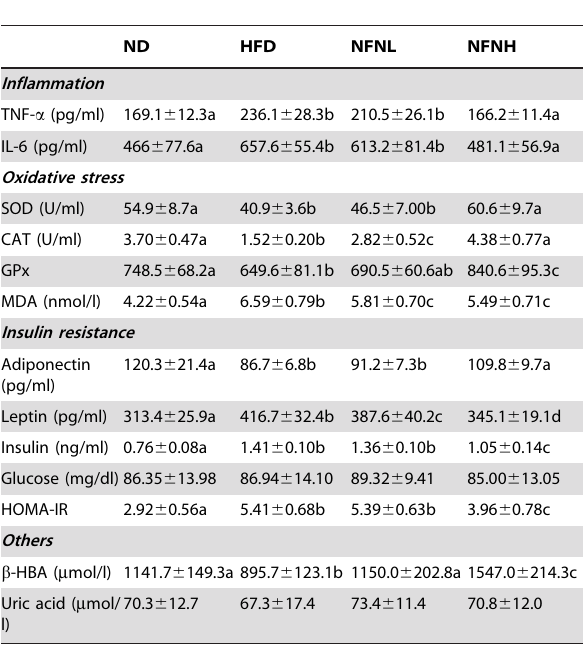
Table 3. Effects of nuciferine on serum biochemical parameters in high-fat-fed hamsters.